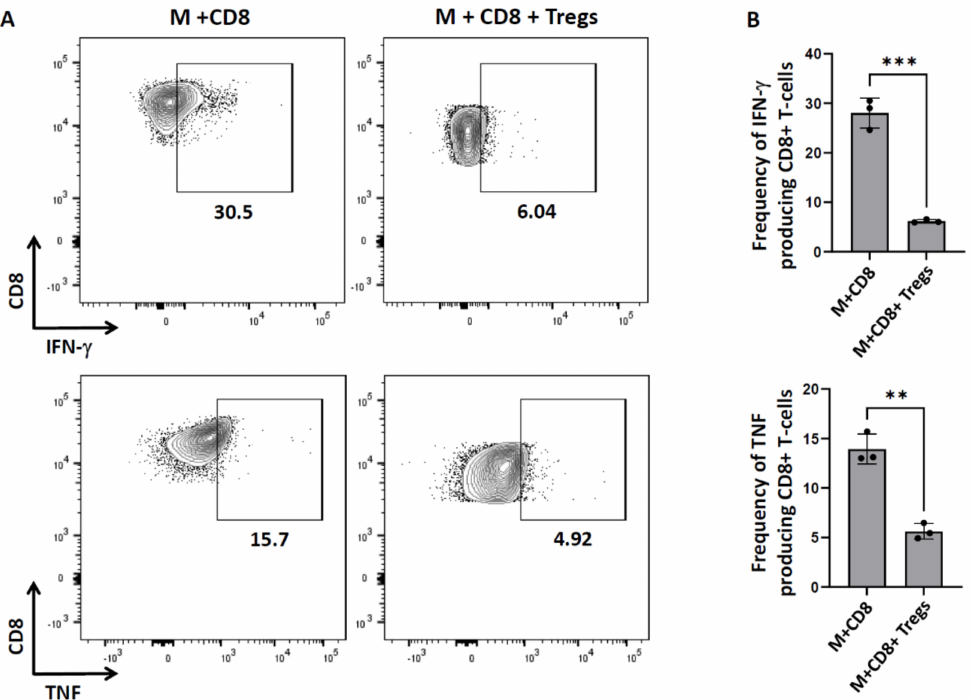
Figure 2. Tregs modulate pro − inflammatory cytokines. In vitro CTL assays were carried out as described previously in Figure 1 using a 1:5 ratio of CD8 + :Tregs. After 18 h of co-culture, CD8 + T − cells were analyzed using flow cytometry. ( A ) Representative contour plots show production of the pro − inflammatory cytokines IFN- γ as well as TNF. ( B ) Bar graphs show the frequency of IFN- γ − and TNF − producing CD8 + T − cells. Data shown are representative of three experi- ments using 3 wells/group/experiment and expressed as mean ± SE. rAd-OVA-primed OT-1 mice ( n = 2/experiment) and IL − 2/anti − IL − 2 − injected C57BL/6 mice ( n = 4/experiment). ** p < 0.01, *** p <